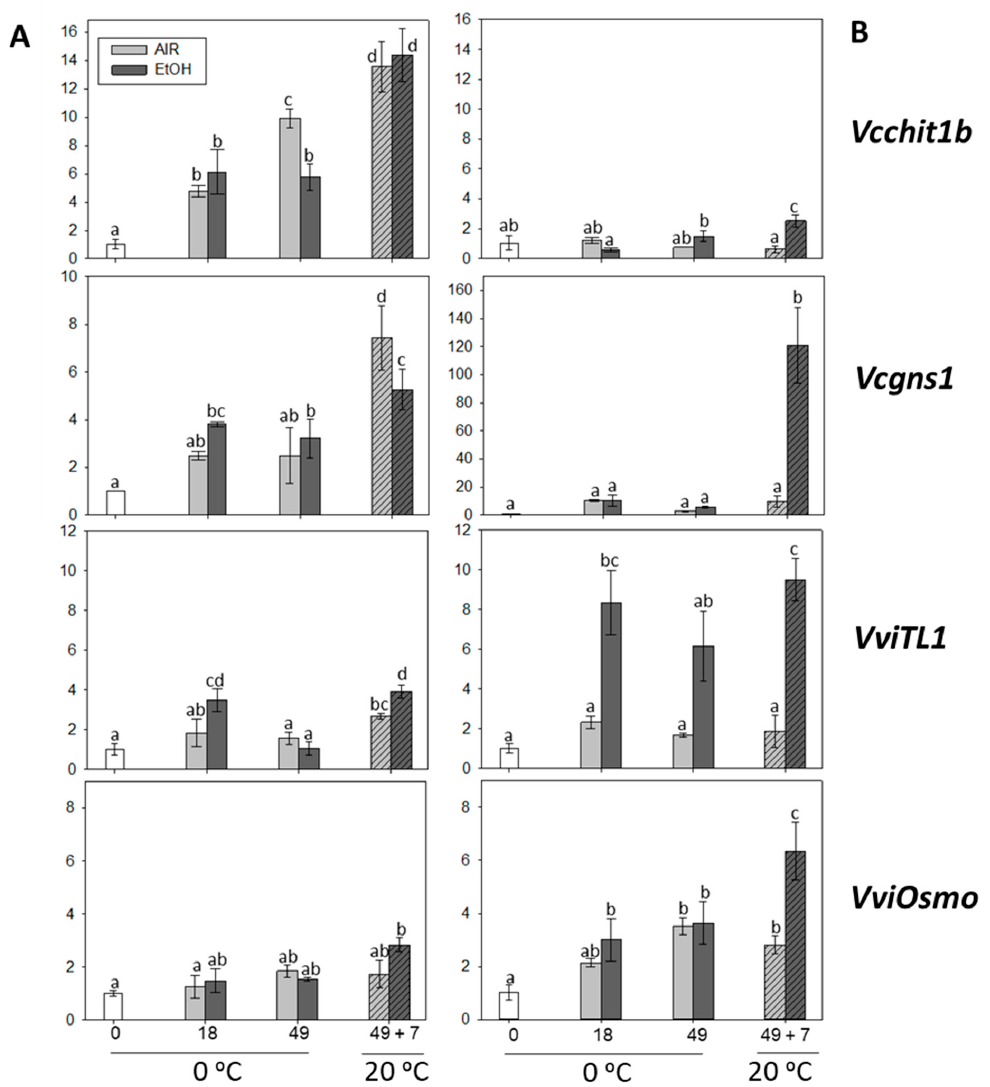
Figure 5. Effect of low temperature and ethanol treatment on PRs gene expression ( Vcchit1b, Vcgns1, VviTL1 , and VviOsmo ) in the skin ( A ) and pulp ( B ) of It 681–30 table grapes stored for 49 days at 0 °C and after the shelf-life period (49 d + 7 d at 20 °C). The transcript levels of each gene were assessed by RT-qPCR and normalized using Actin1 as a reference gene. The results were calculated relative to a calibrator sample (time 0) using the formula 2 −ΔΔ Ct . Values are the mean ± SD, n = 6. Different letters on bars indicate that the means are statistically different using the Tukey-b test ( p < 0.05). Table 3. Pearson correlation between Vcgns1, Vcchit1b, VviOsmo , and VviTL1 from the skin (S) or the pulp (P) of non-treated and ethanol-treated It 681–30 table grapes stored at low temperature and after the shelf-life